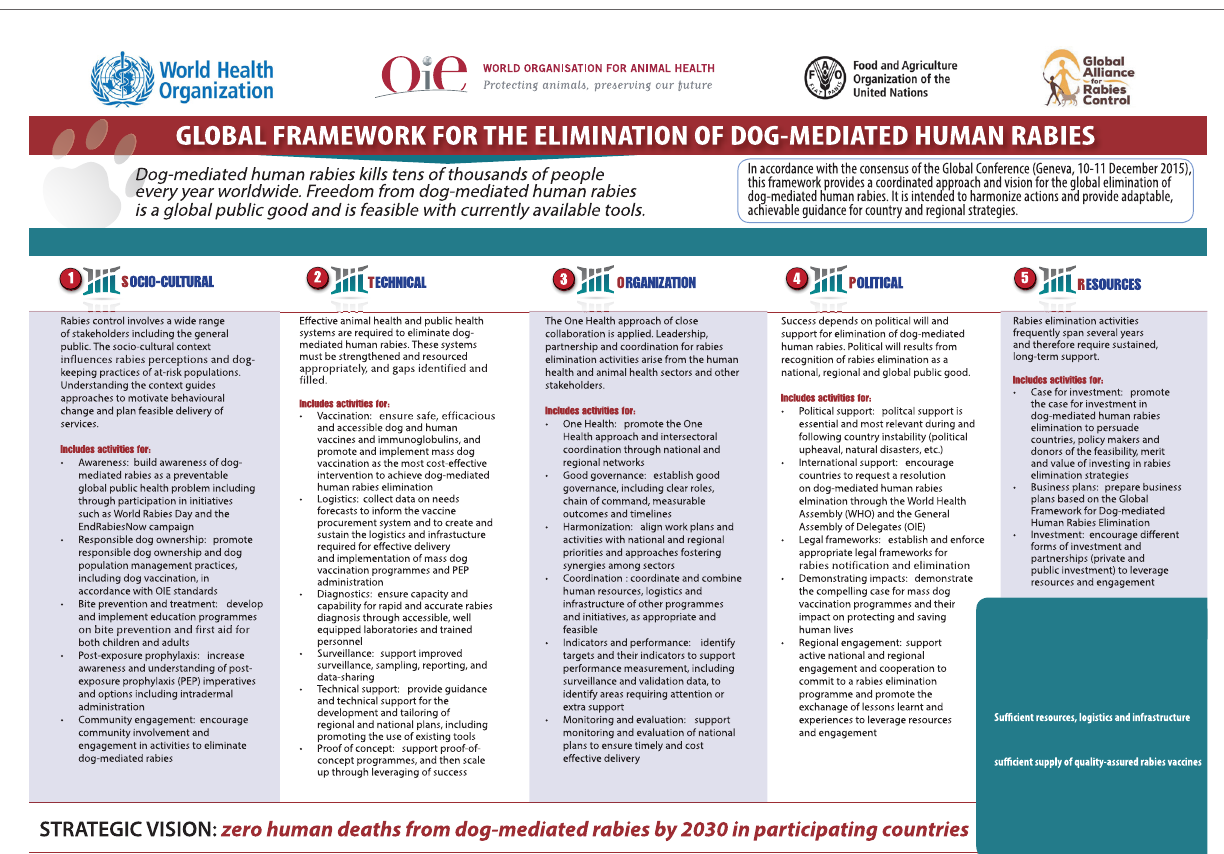
FiGUre 1 | Global framework for the elimination of dog-mediated human rabies